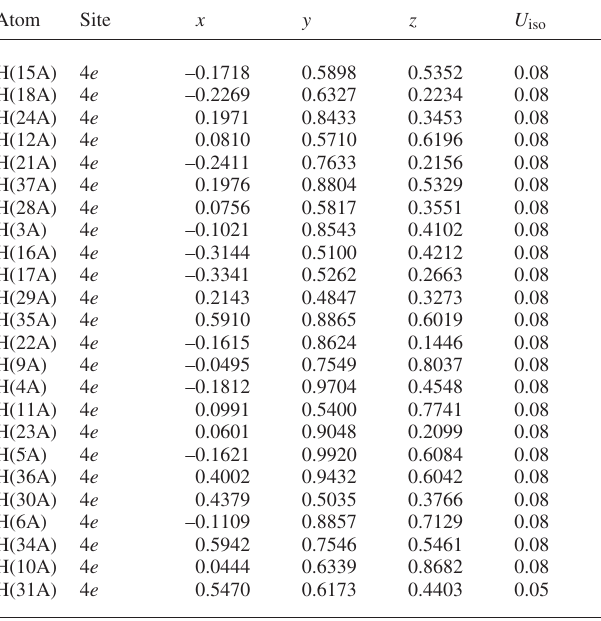
Table 2. Atomic coordinates and displacement parameters (in Å 2 )